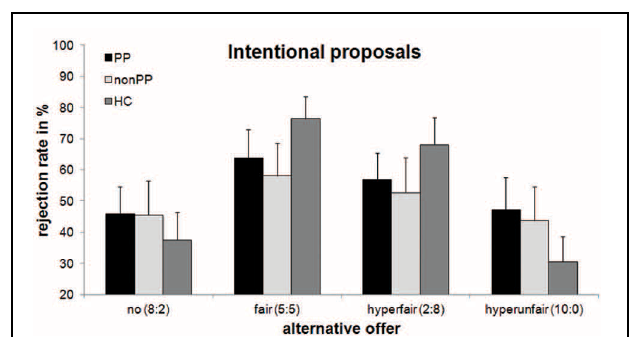
Participants have to indicate via button press whether to accept (“Yes”) or reject (“No”) the offer. Note that for unintentional offers (not shown here), the otherwise black silhouette of the proposer was purple with a banner displaying “Computer chooses,” which was also depicted instead of the proposer’s name.